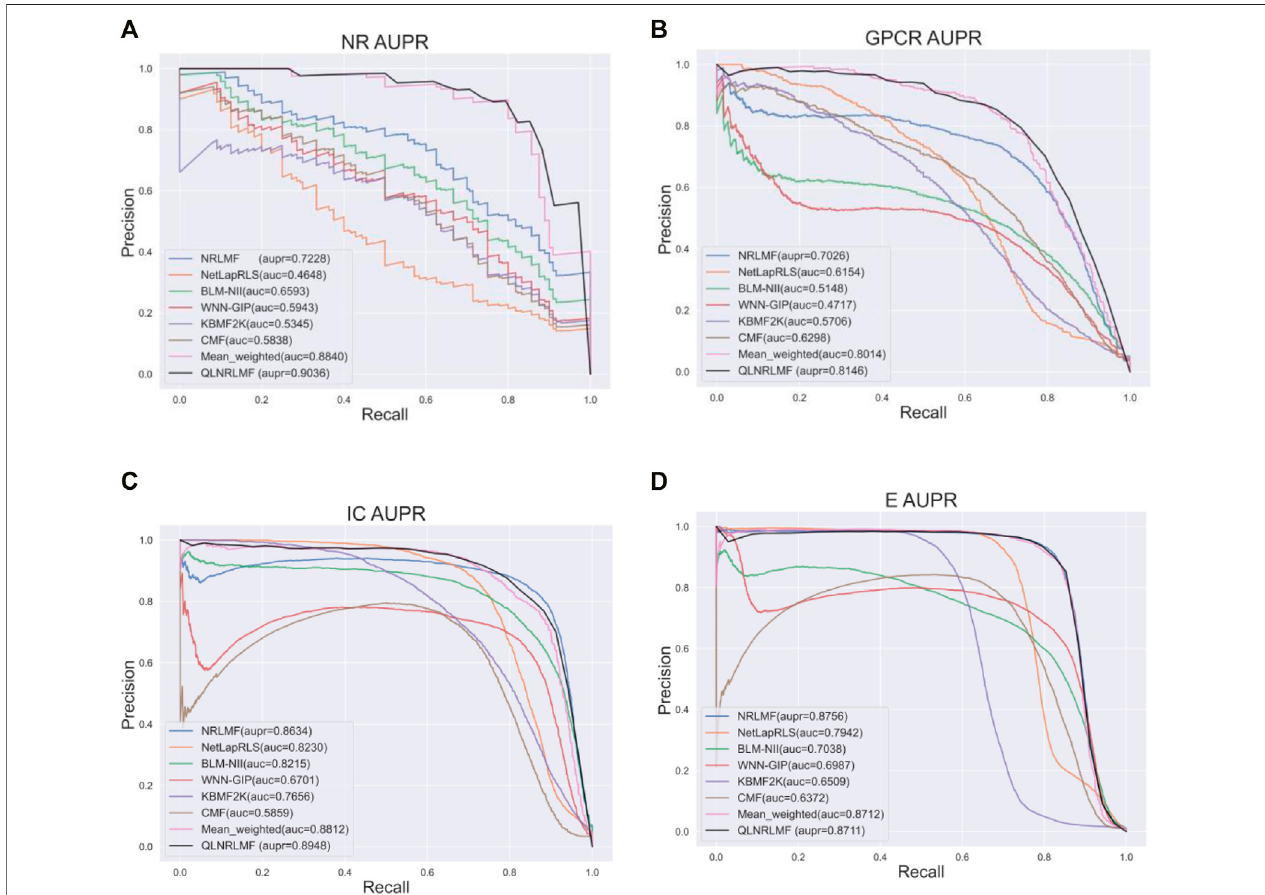
FIGURE 5| The AUPR of QLNRLMF and Other Methods on Benchmark Datasets. (A) The AUPR ofQLNRLMF and Other Methods on NR Dataset. (B) The AUPR ofQLNRLMFandOtherMethodsonGPCRDataset. (C) TheAUPRofQLNRLMFandOtherMethodsonICDataset. (D) TheAUPRofQLNRLMFandOtherMethodson E Dataset.